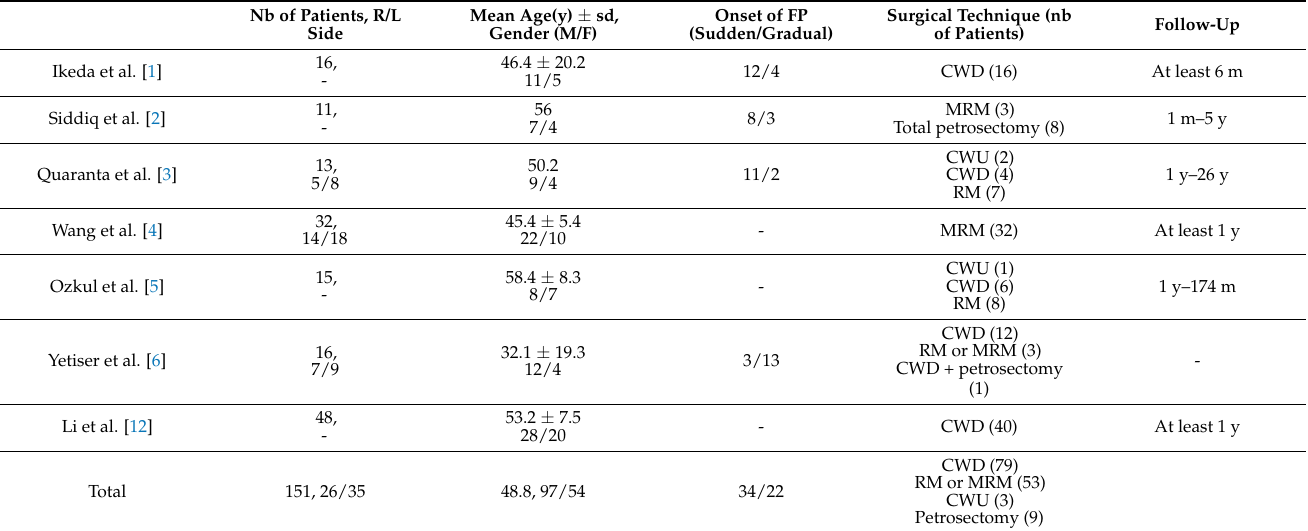
Table 2. Studies including number (Nb) and characteristics of patients, onset of facial palsy (FP), surgical technique for removal of cholesteatoma and postoperative follow-up. CWU: canal wall up mastoidectomy, CWD: canal wall down mastoidectomy, RM: radical mastoidectomy, MRM: modified radical mastoidectomy, m = month, y =